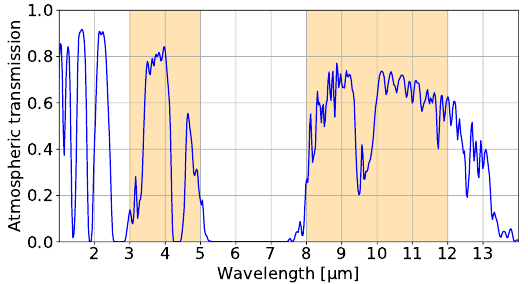
Figure 2. The relative atmospheric transmission in the IR spectrum, the two bands with least absorption are highlighted.